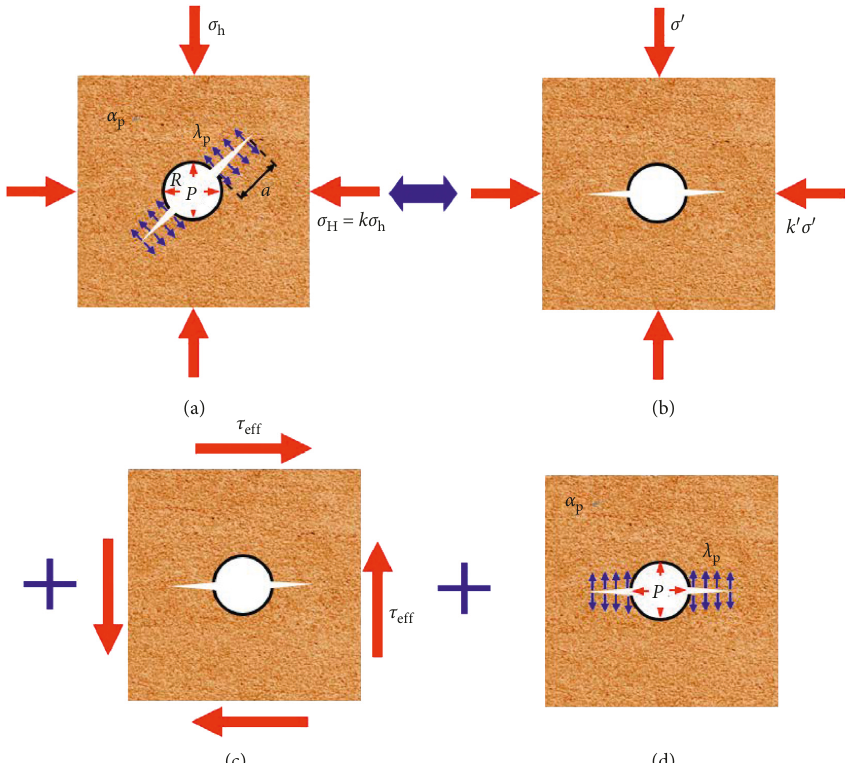
Figure 1: Loading conditions on two inclined symmetrical radial perforations emanating from a borehole. (a) can be created by superposing (b), (c), and